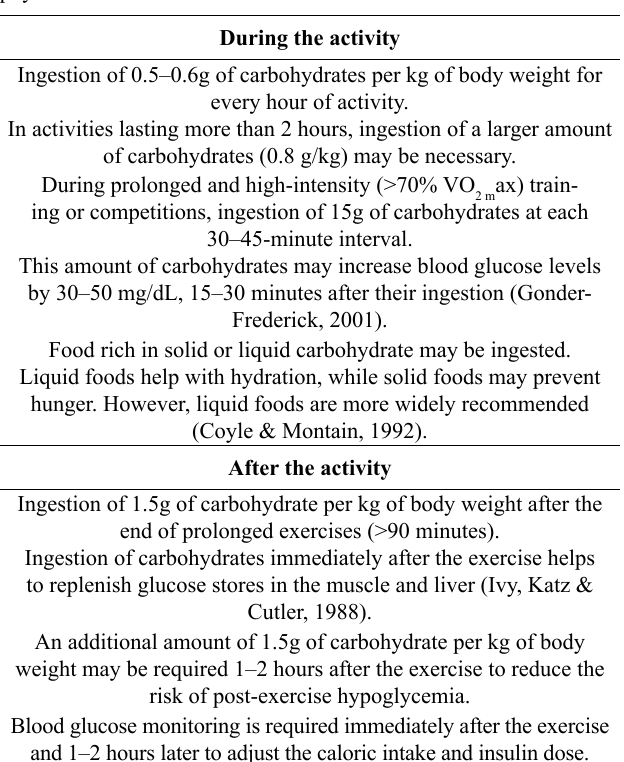
Table 1. Nutritional recommendations for T1DM patients involved in physical activities.